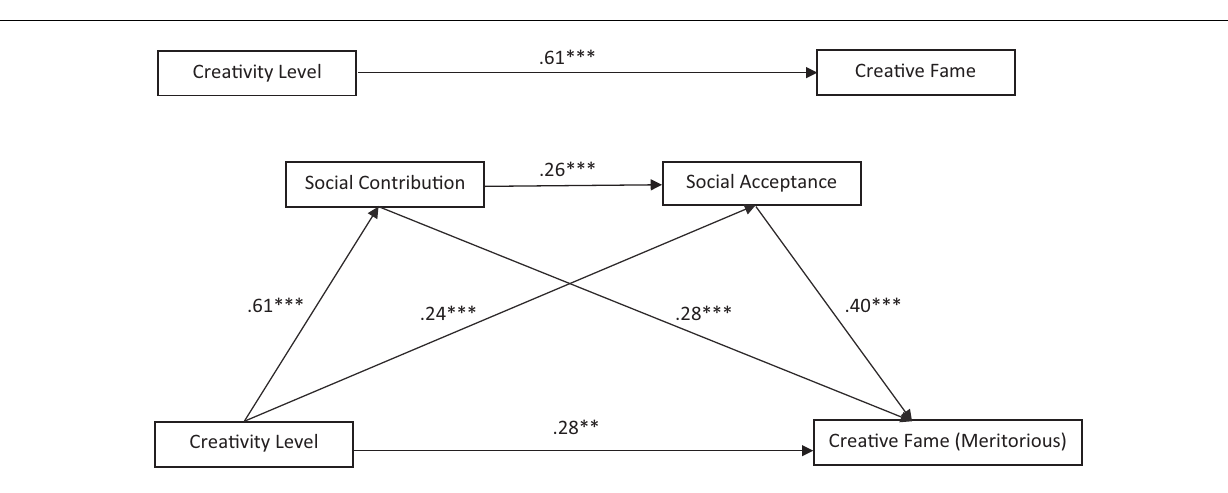
mediating effect of SC and SA was stronger for the nomination from the meritorious areas than the aesthetic